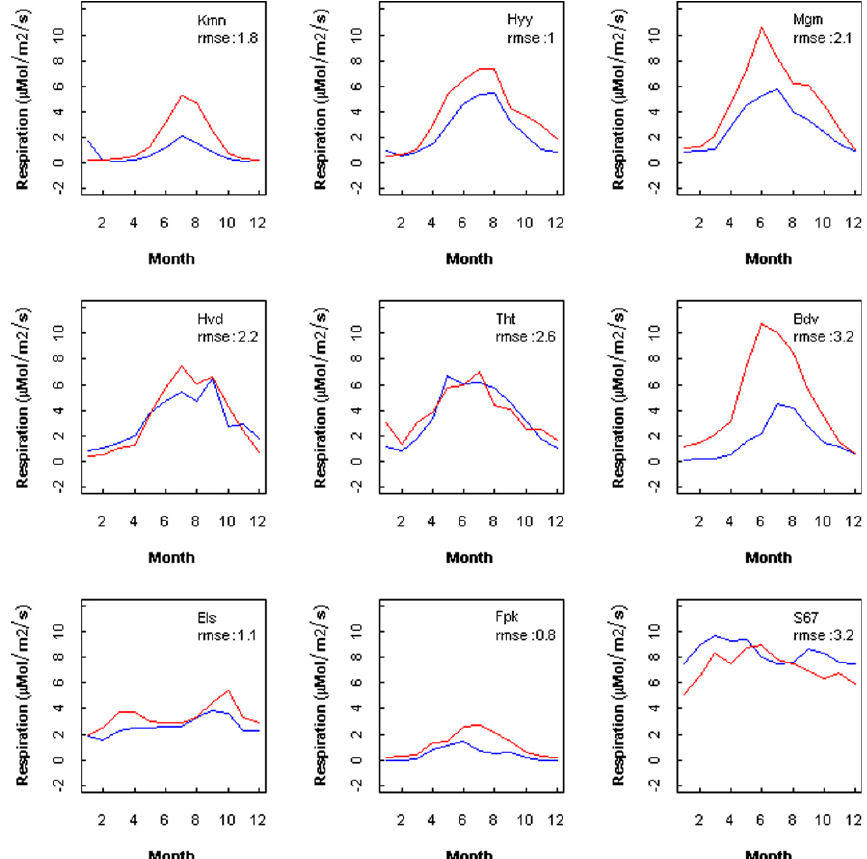
Fig. 4. Modelled (red) and observed (blue) respiration fluxes at 9 FLUXNET sites (Kmn: Kaamanen, Hyy: Hyytiala, Mgn: Morgon Monroe, Hvd: Harvard Forest, Trt: Tharandt, Bdv: Bondville, Els: El Saler, Fpk: Fort Peck, S67: Santarem